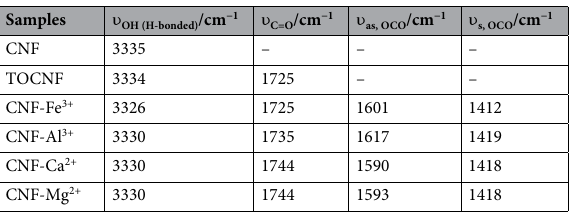
Table 1. IR Wavenumbers for CNF, TOCNF, and TOCNF–M n+ hydrogels.